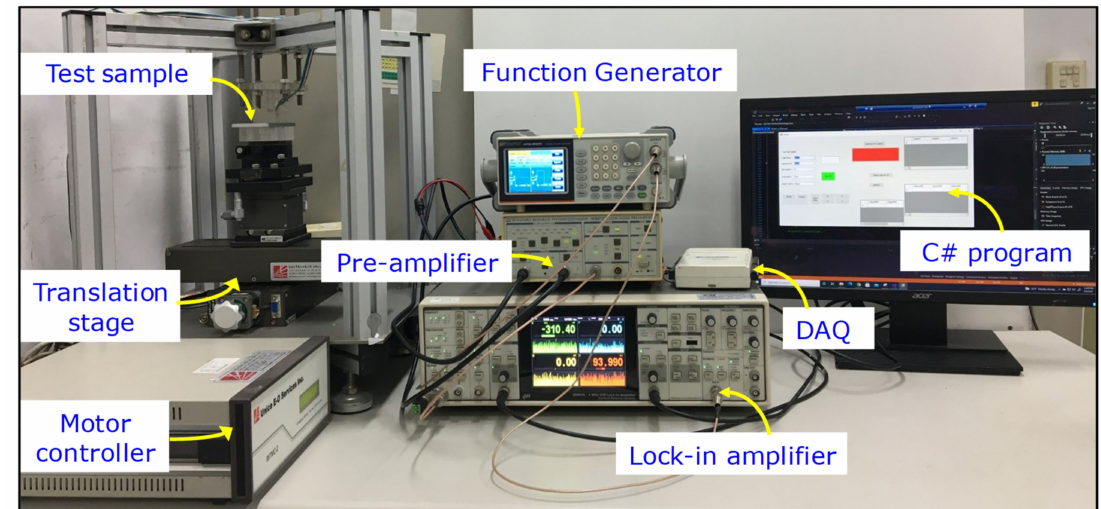
Figure 5. The automatic scanning system for the EC probe based on a half-bridge GMR